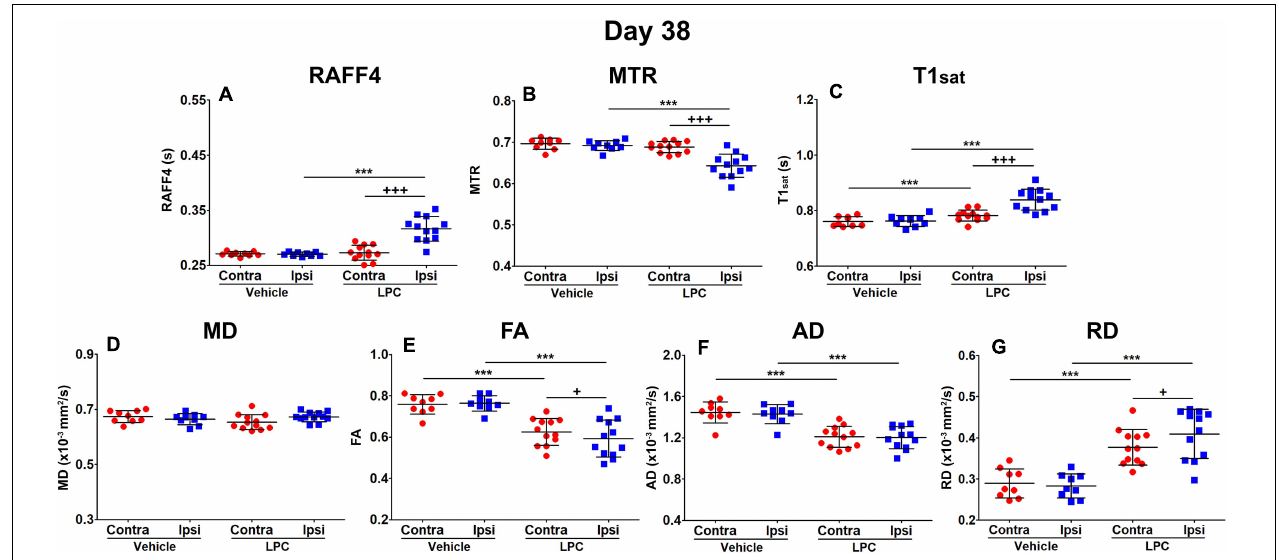
FIGURE 5 | Region of interest analysis of MRI parameters in the remyelinization phase, on day 38: RAFF4 (A) , magnetization transfer ratio, MTR (B) , T1sat (C) , mean diffusivity MD (D) , fractional anisotropy, FA (E) and axial and radial diffusivity, AD (F) and RD (G) . Values obtained from the ipsilateral and contralateral side of LPC injected ( n = 12) rats and from the corresponding ROI in the vehicle injected ( n = 9) rats. Mean ± SD , paired (+) or unpaired (*) t -test, FDR corrected p -values: + < 0.05, *** or +++ <